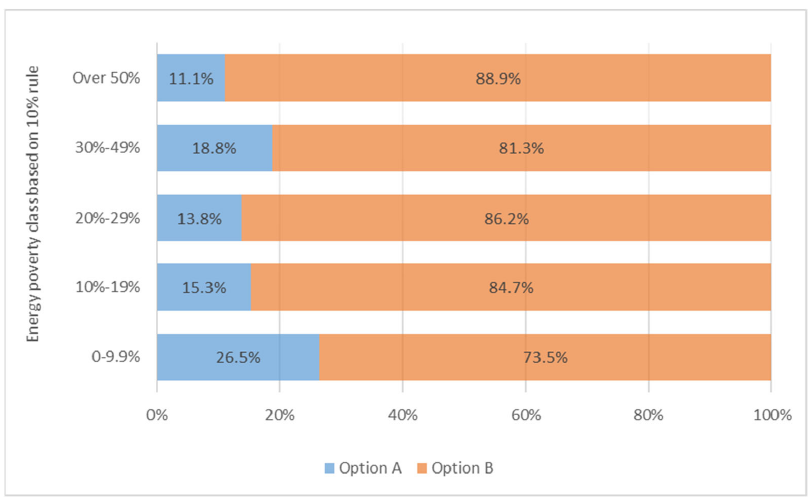
Figure 13. Present bias investigation by energy ‐ vulnerable and non ‐ vulnerable households—“ten percent rule” indicator.